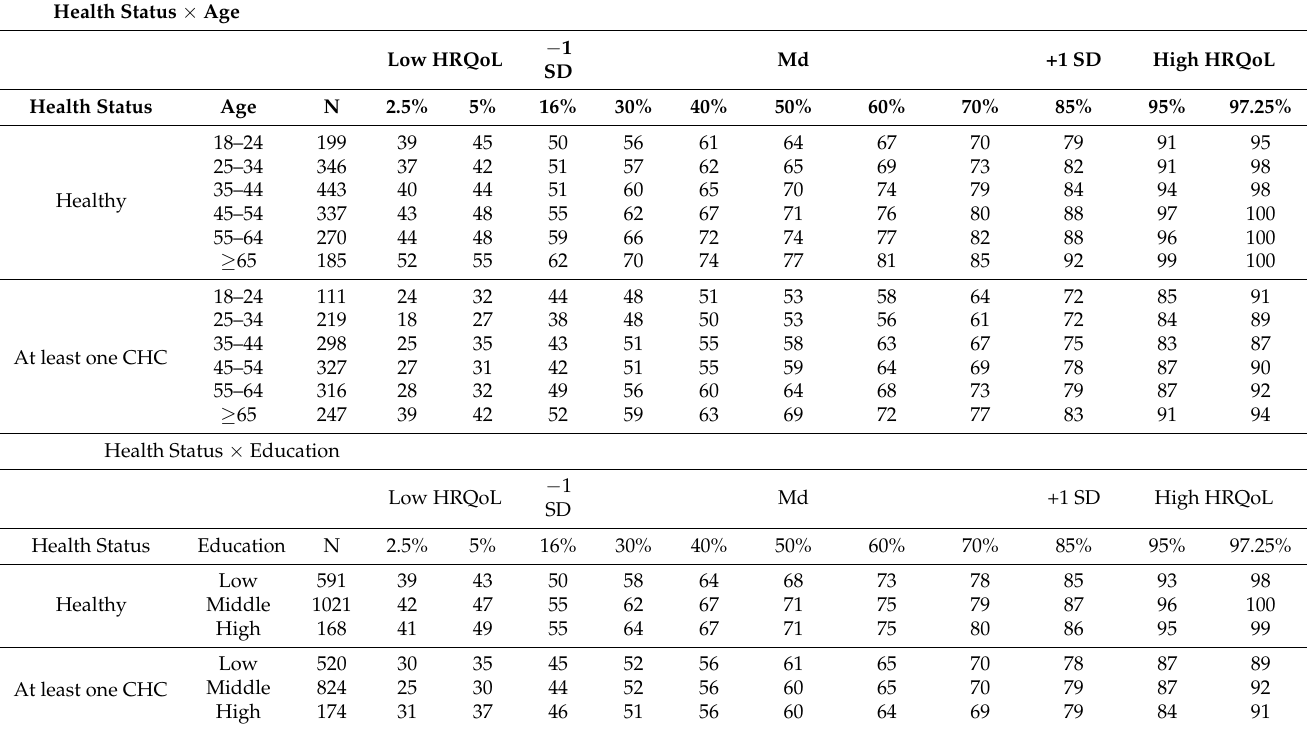
Table A3. Reference values for the QOLIBRI total score obtained from the general population sample in Italy stratified by health status, age, and